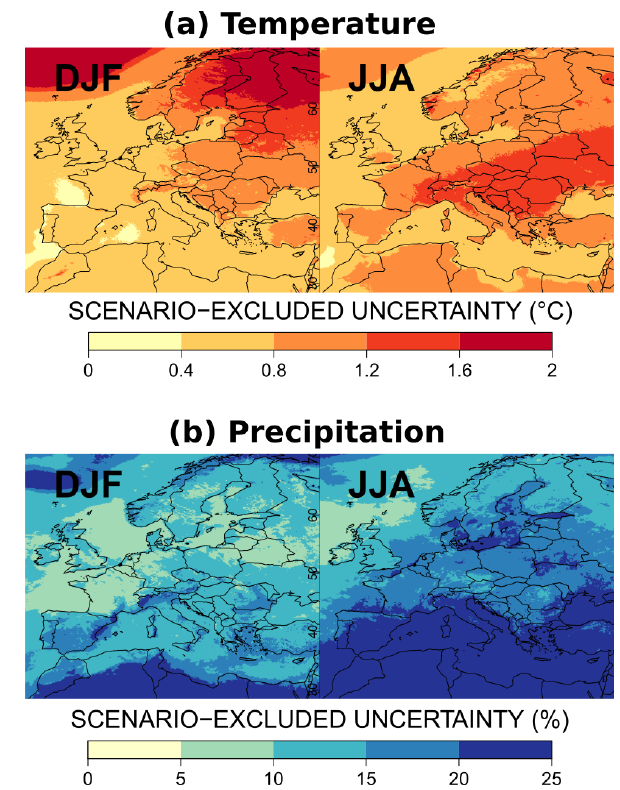
Figure 6. Scenario-excluded uncertainty (balanced estimates) BU of the climate change responses at the end of the 21st century (2071–2099) compared to the period 1981–2010. Absolute tem- perature change (a) and relative precipitation change (b) in winter (DJF) and summer